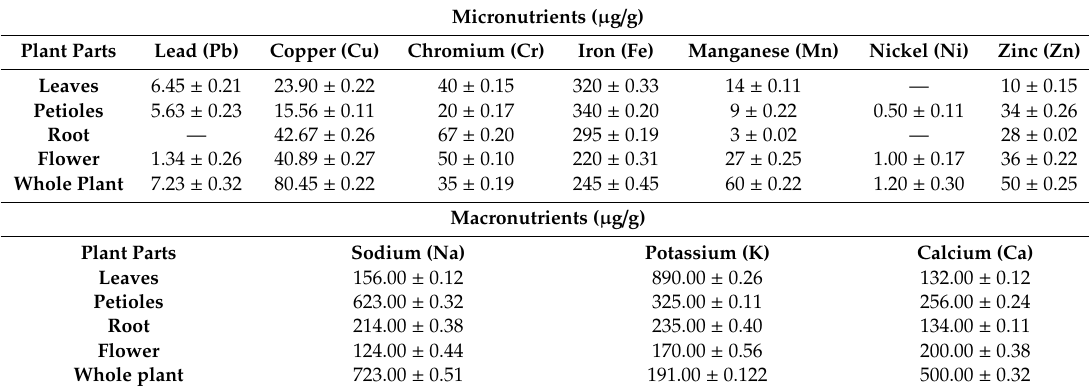
Table 2. Micro- and macronutrients in di ff erent parts of V. betonicifolia.